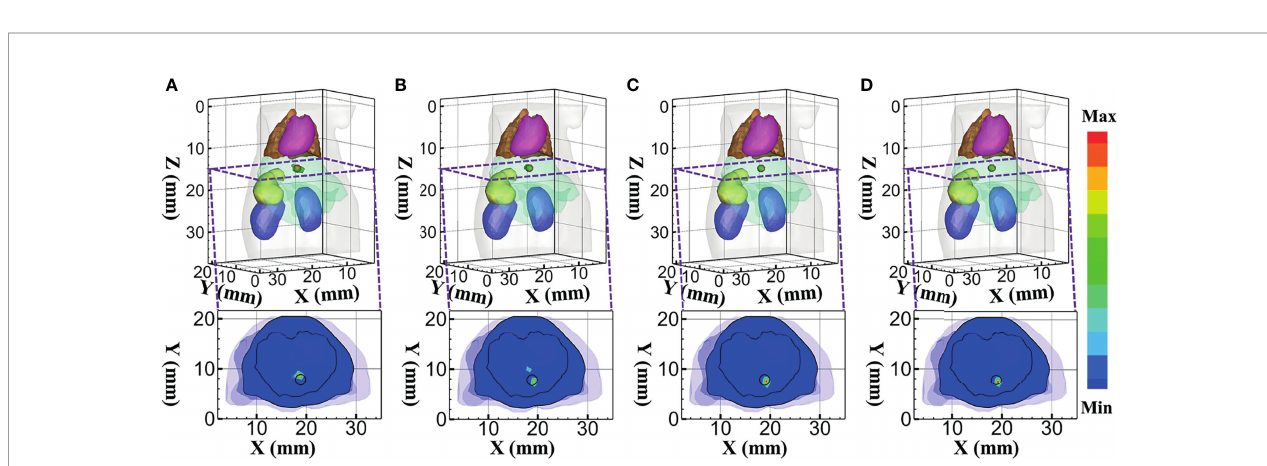
FIGURE 7 | Reconstructed results at 610 nm. (A – D) 3D views of the reconstructed results and the corresponding sectional images obtained by the DE-, SP 3 -, HDSM-, and MRHM-based methods,